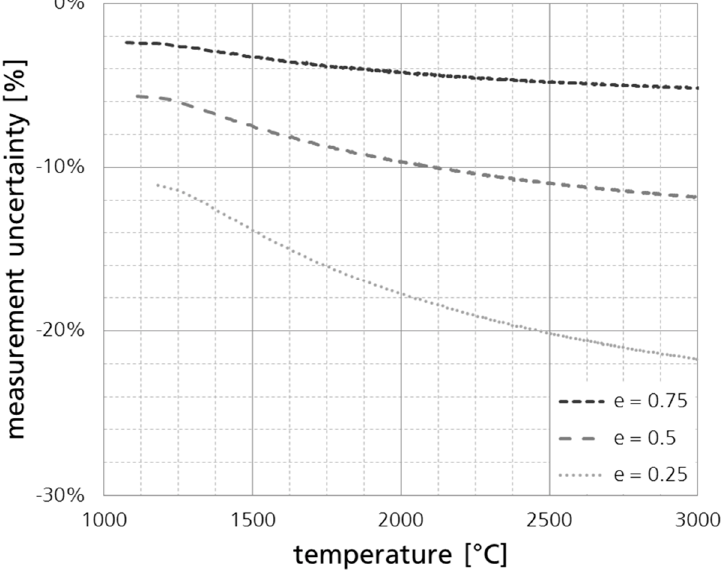
Figure 4. Measurement uncertainty as a function of the real temperature and different emission coefficients to correct the measured temperatures.